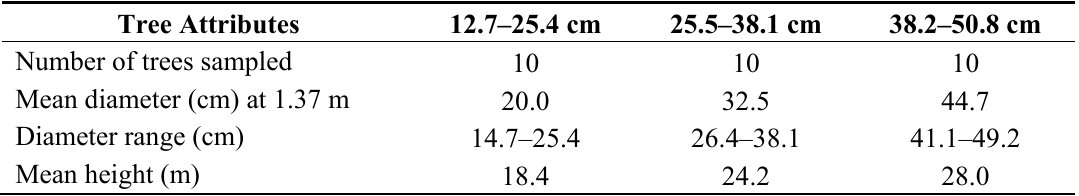
Table 2. Characteristics of the Douglas-fir trees sampled for stem moisture content loss